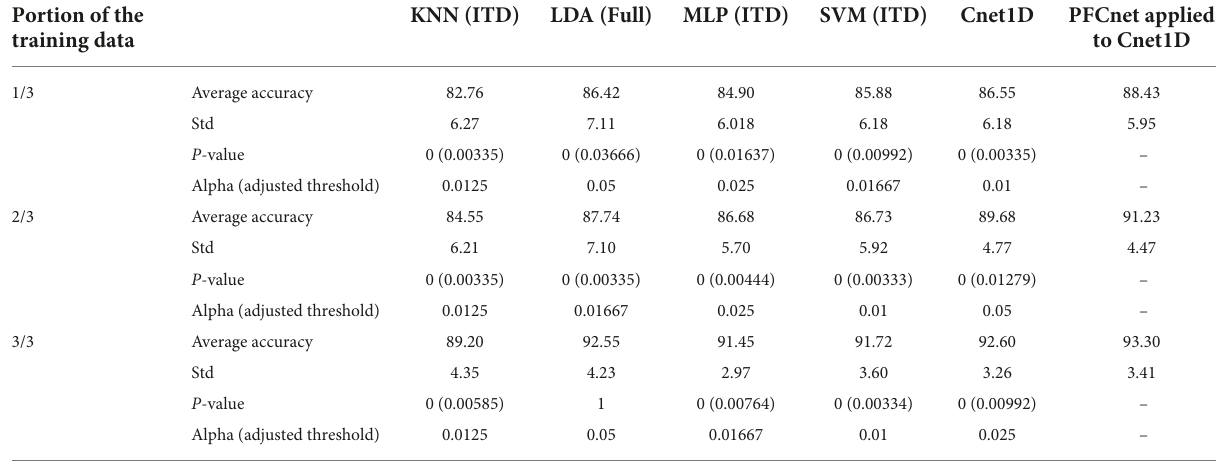
TABLE 5 Comparison between classical classifiers and proposed transfer learning method combined with Cnet1D, when different sizes of target’s training subset are used for training for Nearlab dataset ( N = 11) with 8 movement classes (chance accuracy level = 12.5%). Portion of the training data